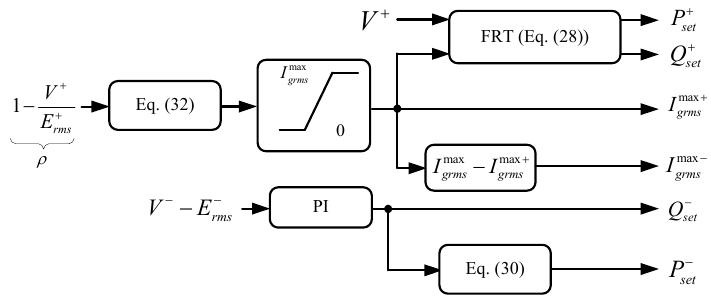
Figure 2. Implementation diagram of the proposed controller.